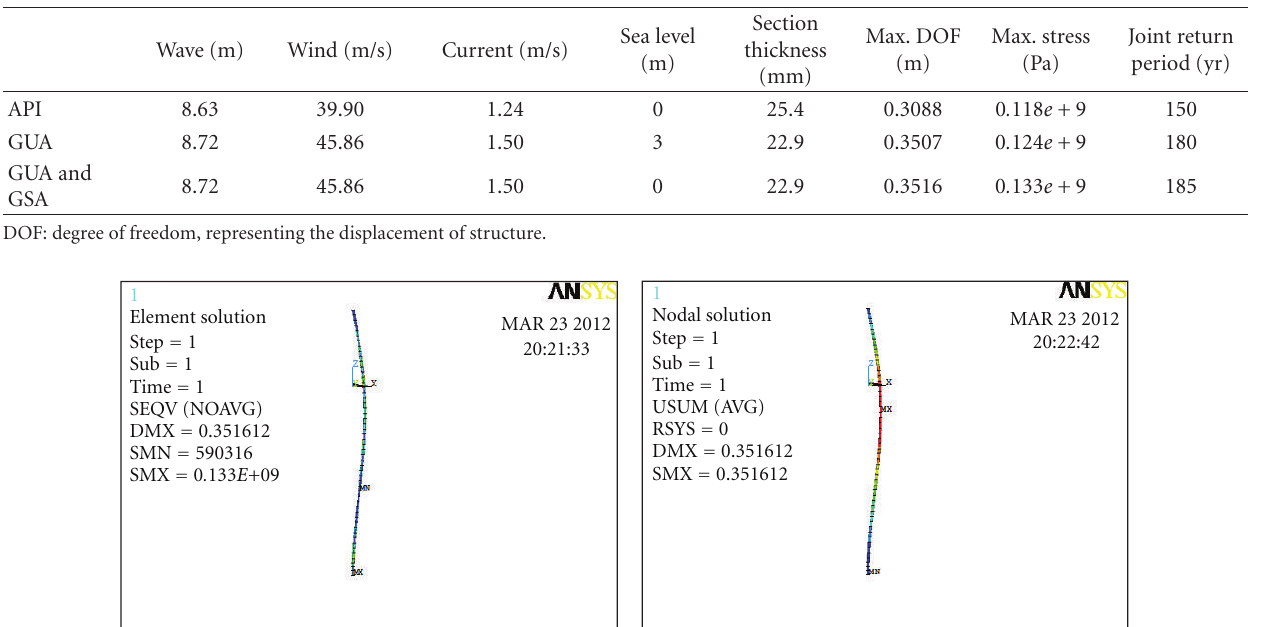
Table 10: Comparison of calculated results by di ff erent definitions.